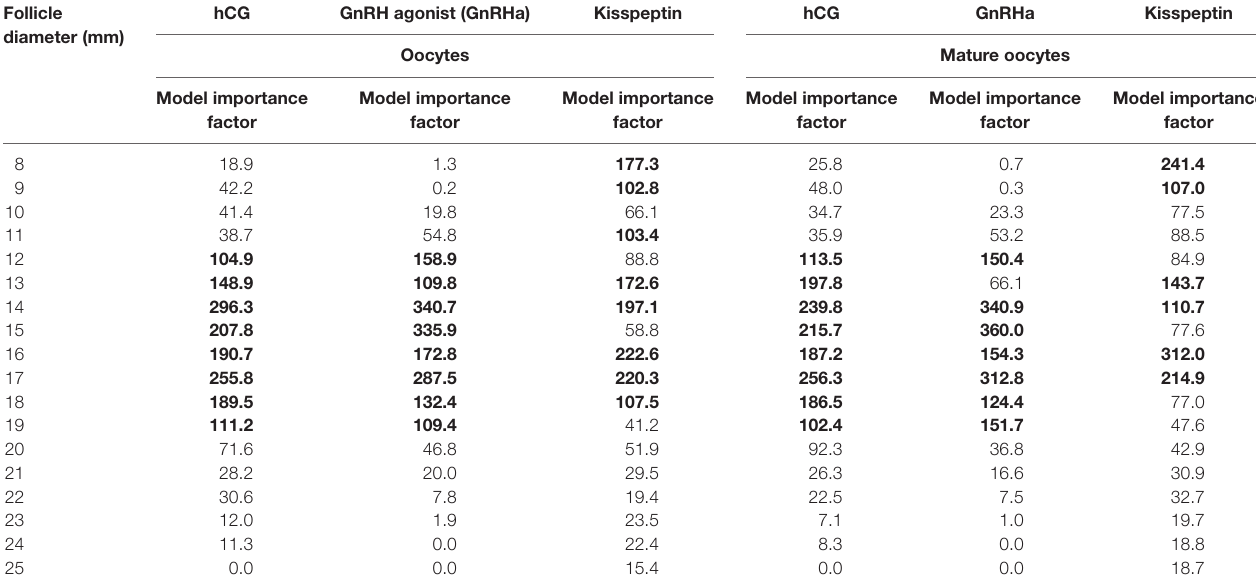
Table 3 | Model importance factors (random forest) for follicle diameter in determining number of oocytes and number of mature oocytes.